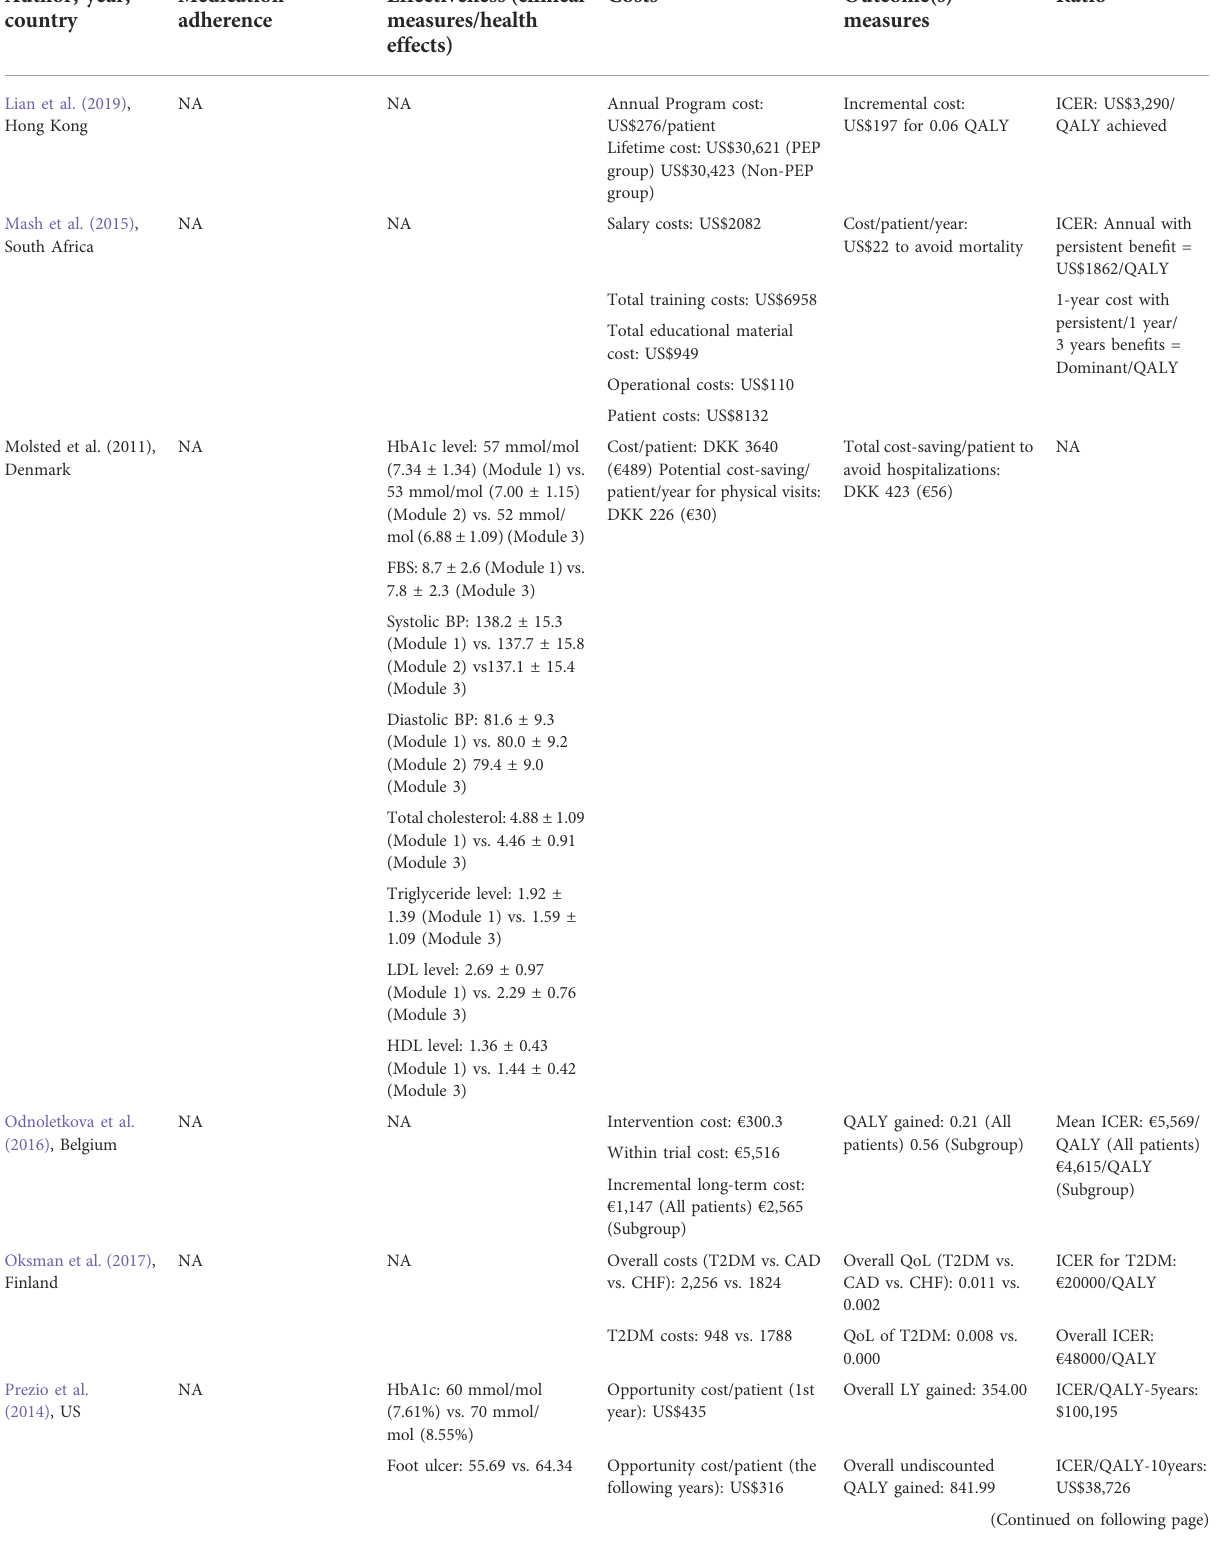
TABLE 2 ( Continued ) Effectiveness and economic outcomes of a systematic review of the cost-effectiveness of different types of educational interventions in type II diabetes